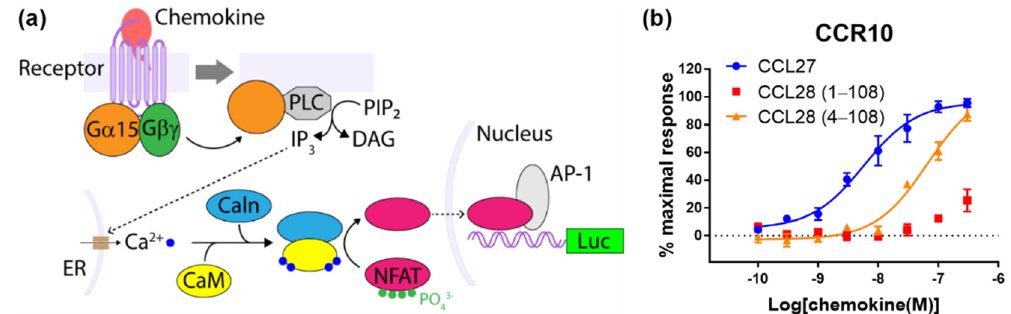
Figure 4. Activation of CCR10 stimulates intracellular Ca 2+ mobilization. ( a ) The principle of the NFAT activation assay. Activation of a chemokine receptor leads to phospholipase C (PLC) activation via the transiently expressed G α 15 , giving rise to downstream release of Ca 2+ from the endoplasmic reticulum (ER). Binding of Ca 2+ to calmodulin (CaM) then enables activation of the protein phosphatase calcineurin (Caln), which catalyzes dephosphorylation of NFAT, enabling its translocation into the nucleus and transcription of the reporter firefly luciferase gene from an NFAT-sensitive reporter construct. ( b ) Chemokine-induced NFAT activation via CCR10. The presented data are mean ± SEM of at least three independent experiments, each performed in triplicate.